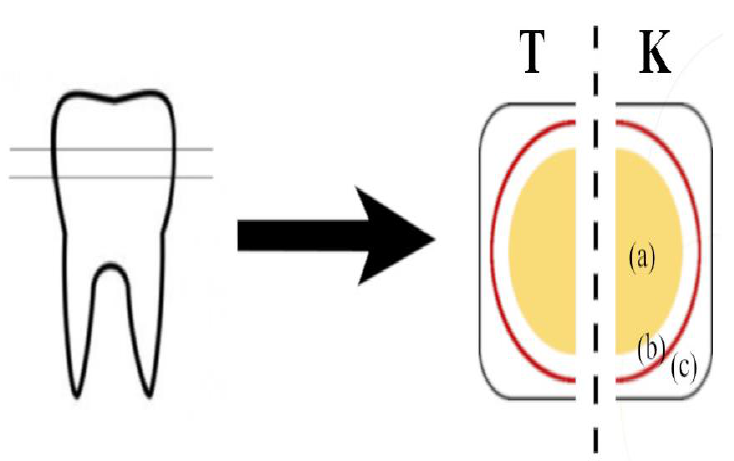
Figure 1. Preparation of enamel and dentin discs: ( T ) test group; ( K ) control group; (a) dentin; (b) enamel; (c) transparent epoxy resin.